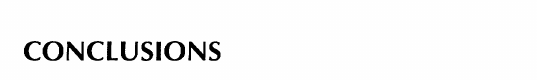
7 from 0 to 50, the buckling load predicted here